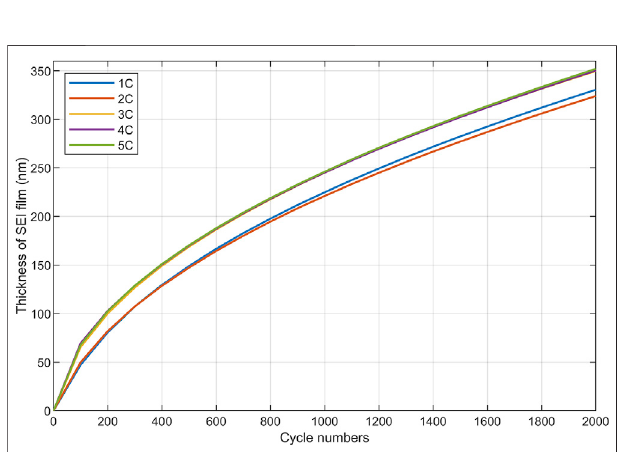
FIGURE 4 | In fl uence of charge rate on SEI fi lm growth at room